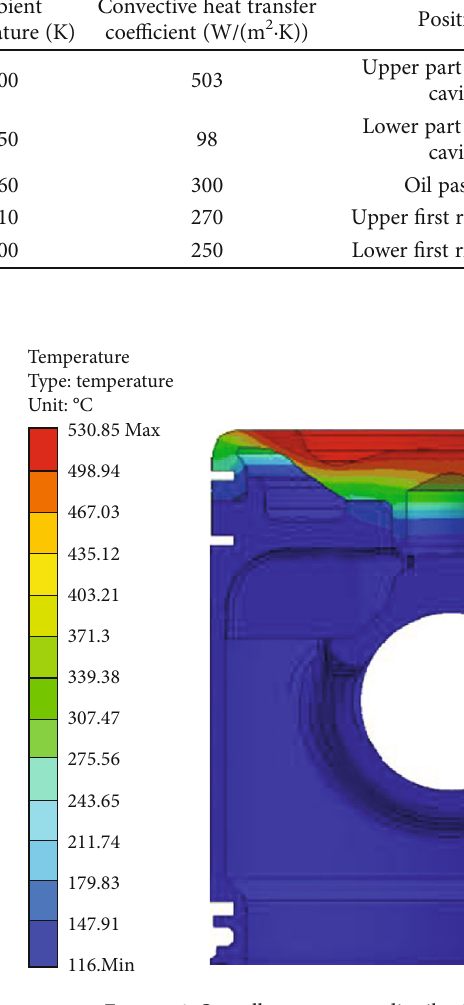
Figure 6: Overall temperature distribution of the